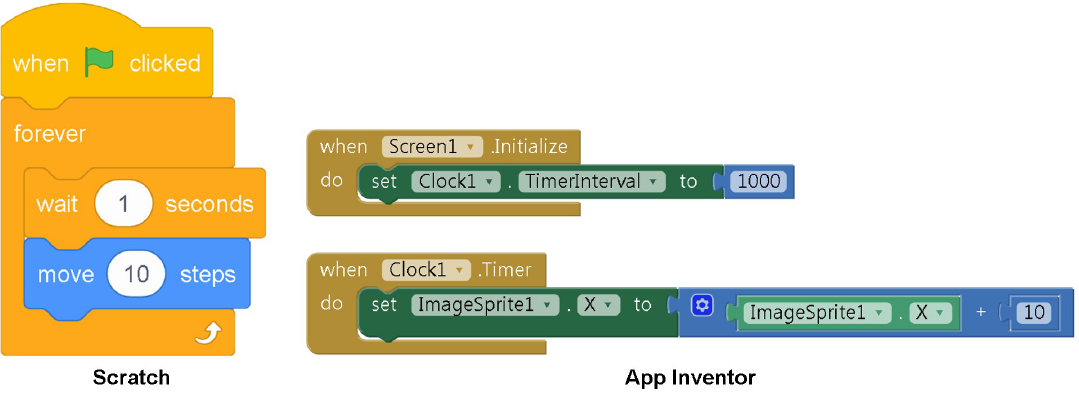
Figure 1. An example of Scratch and App Inventor codes that work in the same way. If we run the Scratch code on the left side of the Figure, the corresponding sprite moves ten steps every second. Likewise, if we run the App Inventor code on the right side of the Figure, the “ImageSprite1” component moves ten steps every